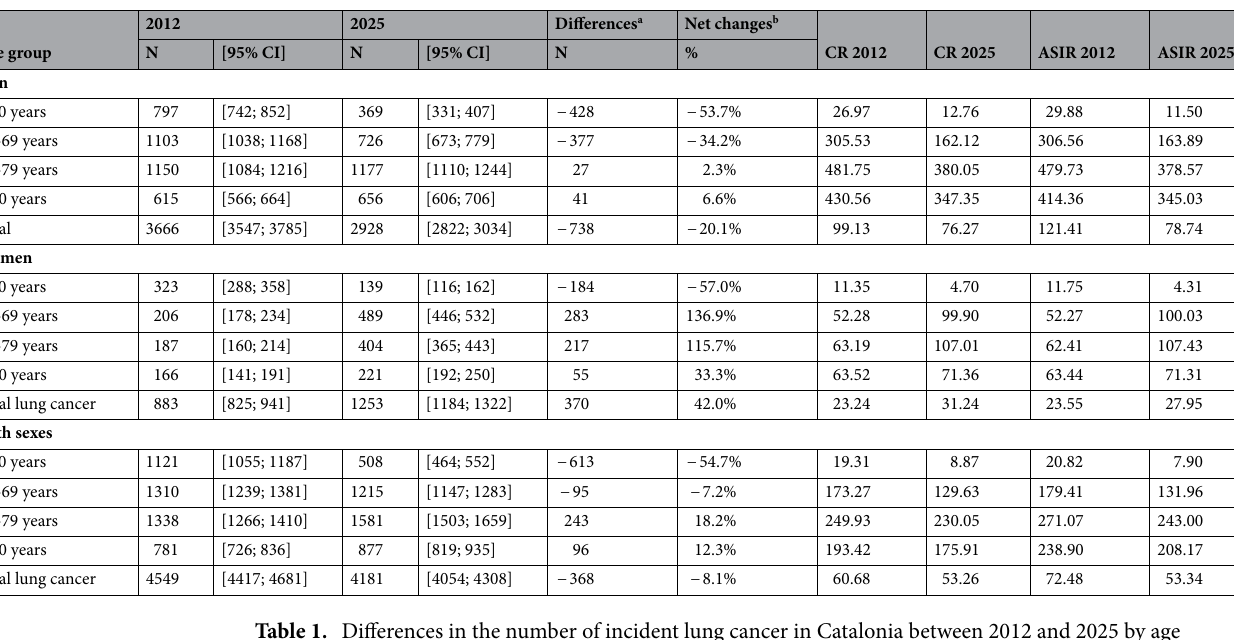
Table 2. Differences in the number of incident lung cancer cases in Catalonia between 2012 and 2025 by histology. CI confidence interval, NOS not otherwise specified. Others contains several histological types of